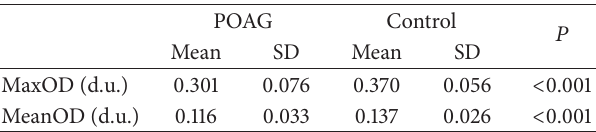
Table 2: Comparison of macular pigment optical density values in two groups. POAG MaxOD (d.u.) MeanOD (d.u.)